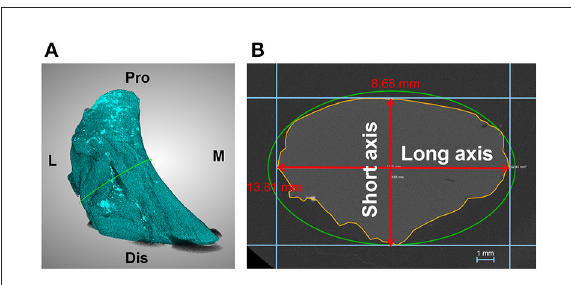
FIGURE4 Measurement of dimensions of the ACL isthmus. (A) ACL substance reconstructed in Dragonfly. (B) Cross sectional area and long axis and short axis of the ACL isthmus (enclosed by yellow line) was measured on the isthmus plane. M, medial; L, lateral; Pro, proximal; Dis, distal.